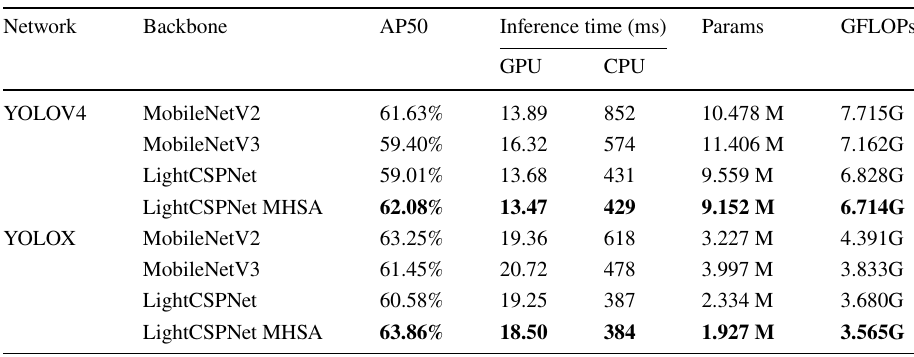
comparison among different backbone